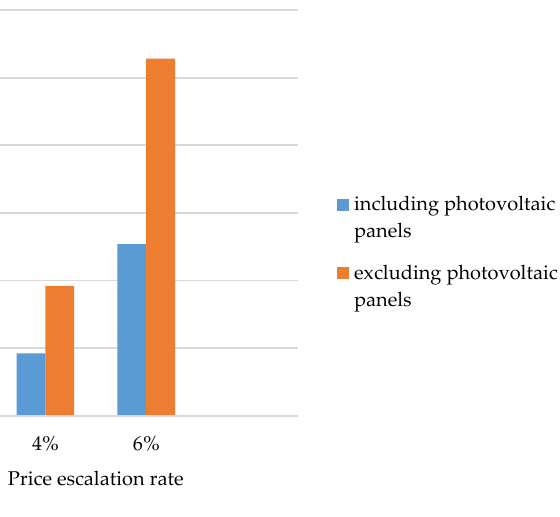
Figure 6. Energy costs estimation for PV panel system.